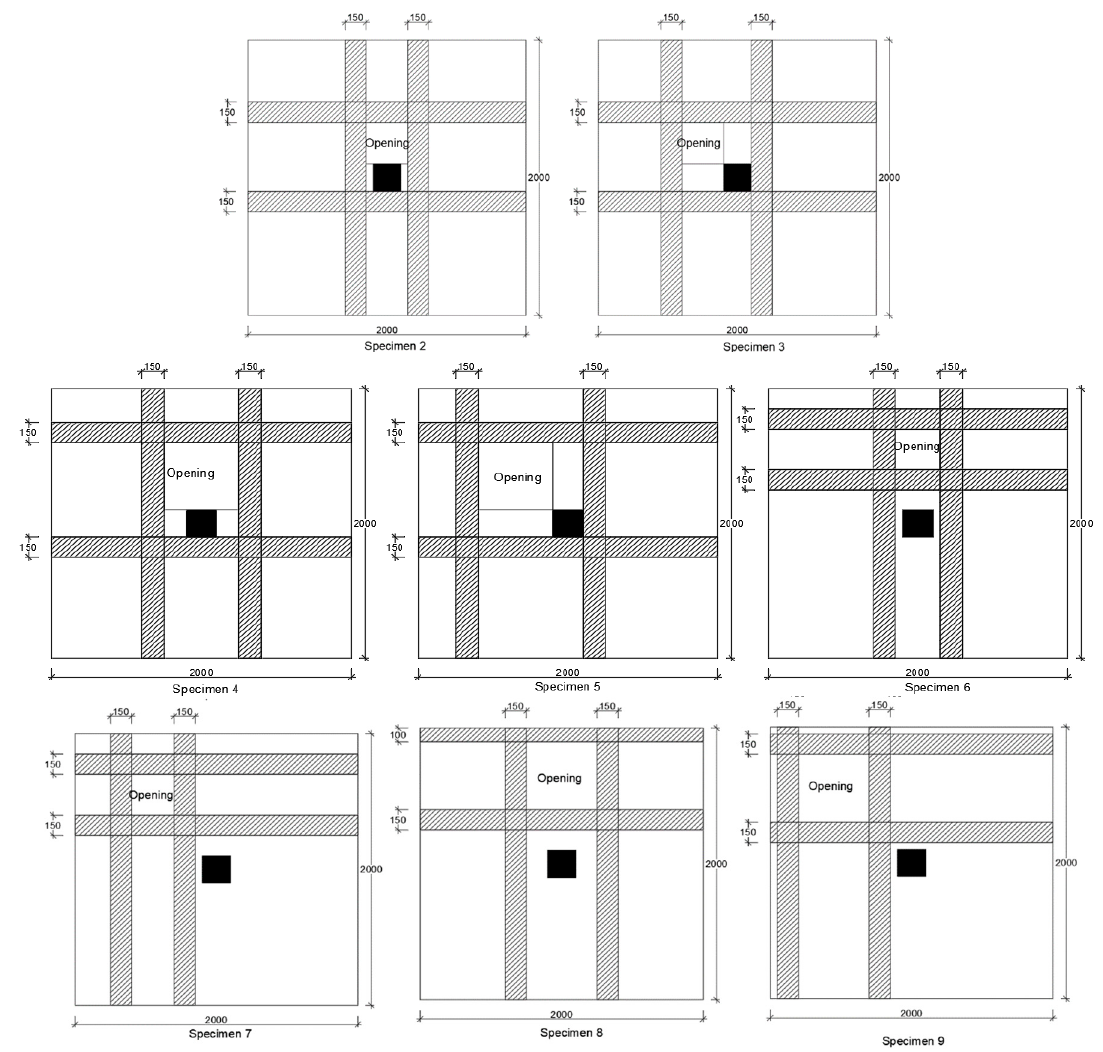
Figure 22. CFRP strips strengthening openings at various locations close-to or further-from the support [44]. support